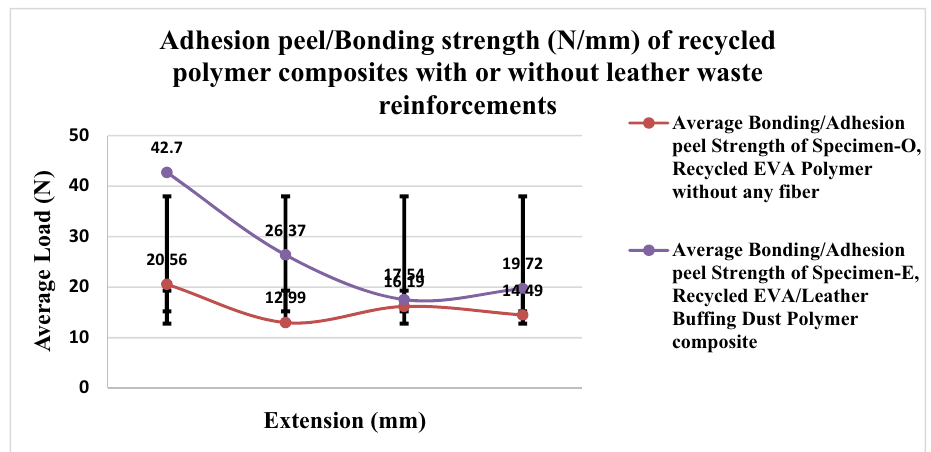
Figure 38: Comparison of average peel load ( N ) against extension ( mm ) of recycled EVA polymer composites with or without leather bu ffi ng